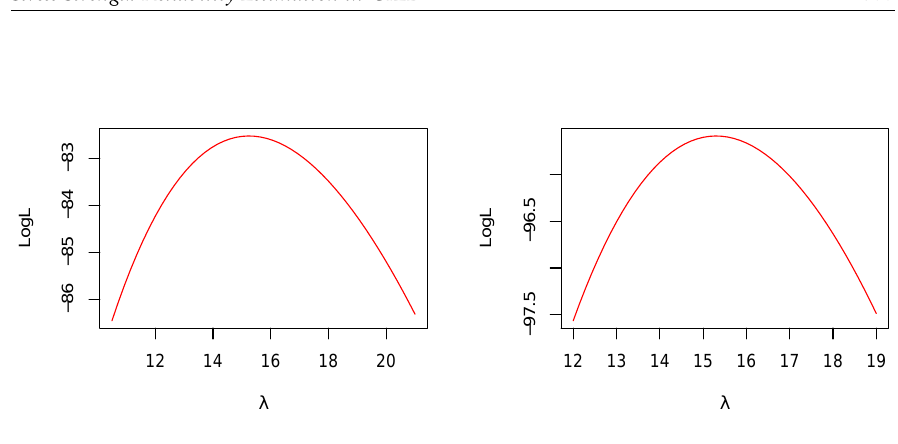
Figure 3 – The plots of profile log-likelihood of λ for data sets corresponding to censoring schemes ( CS ) and ( CS ) , respectively. , CS , CS 1 2 3 4